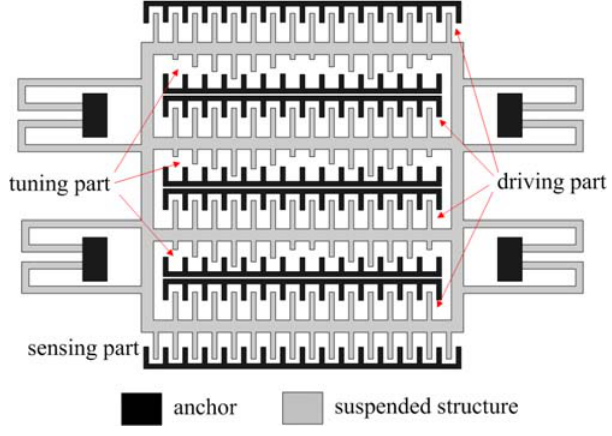
Figure 1. Schematic structure of the tunable